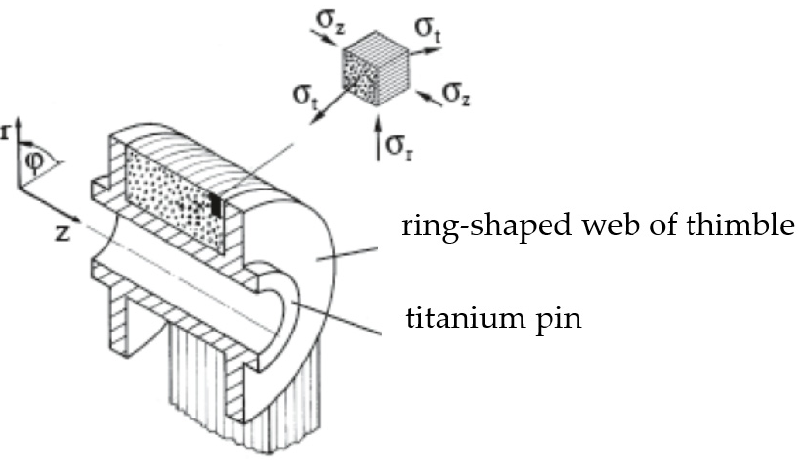
Figure 11. UD CFRP strap supported laterally by ring-shaped webs of the thimbles. Reprinted with permission from [10].